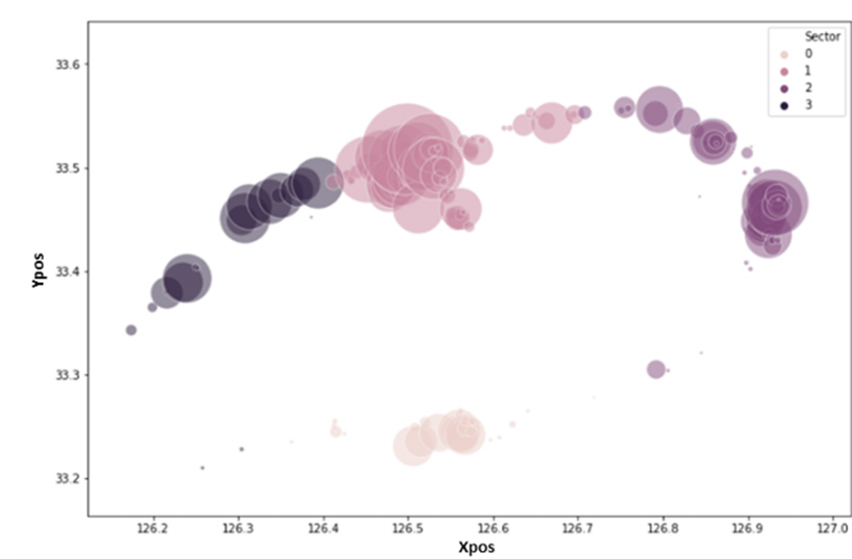
Figure 3. Visualization graph for sectors divided using the clustering